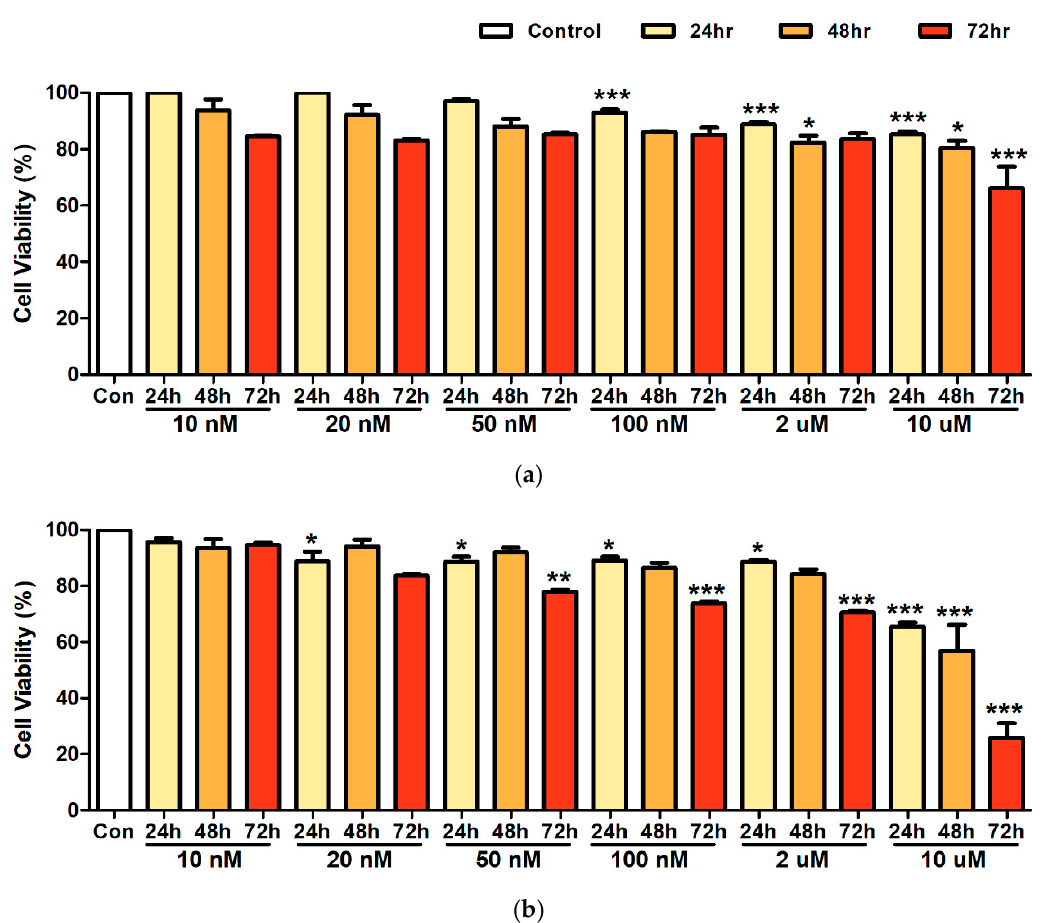
Figure 1. A594 lung cancer cell viability after exposure to Nickel ( a ), and Cadmium ( b ) at concentrations 10 nM, 20 nM, 50 nM, 100 nM, 2 µM, and 10 µM. Bars represent means ± standard deviation. *** p < 0.001, ** p < 0.01, * p < 0.05 vs. control.